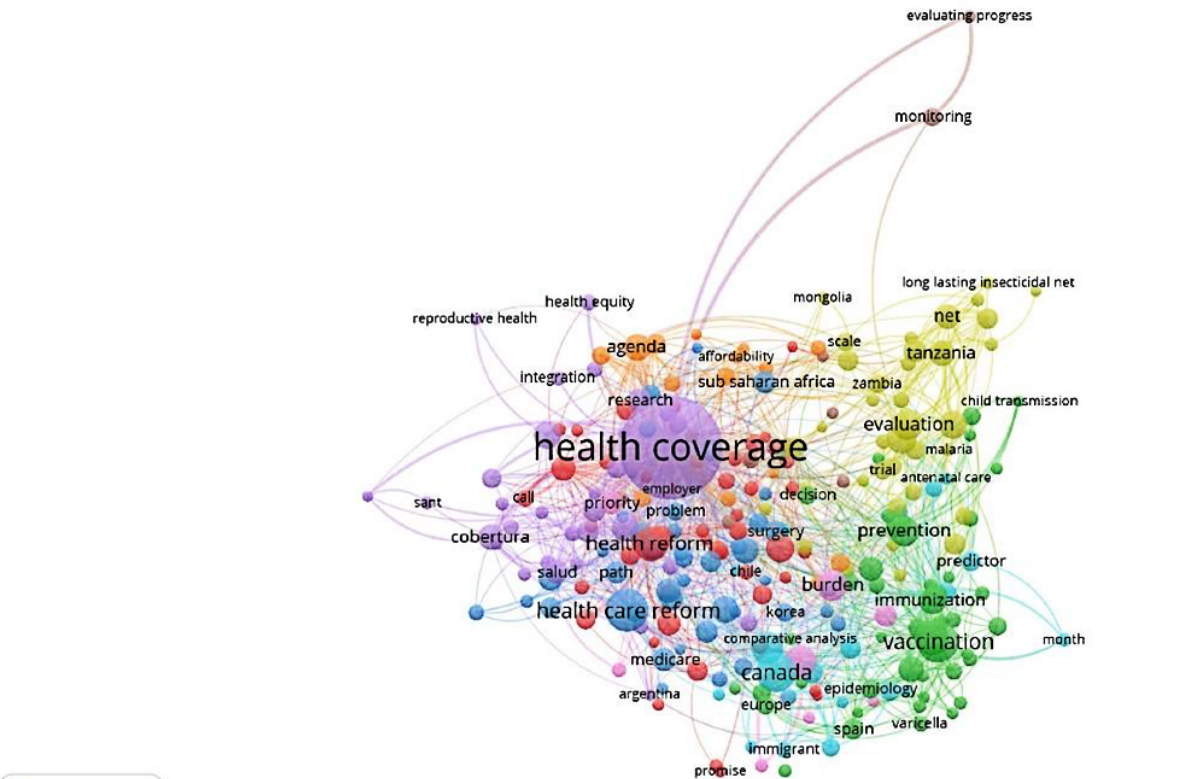
Figure 3. Network of the most used keywords related to universal health